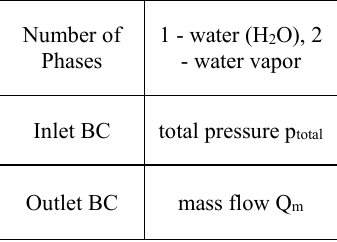
Table 2. BC for inducer with pump CFD calculation.